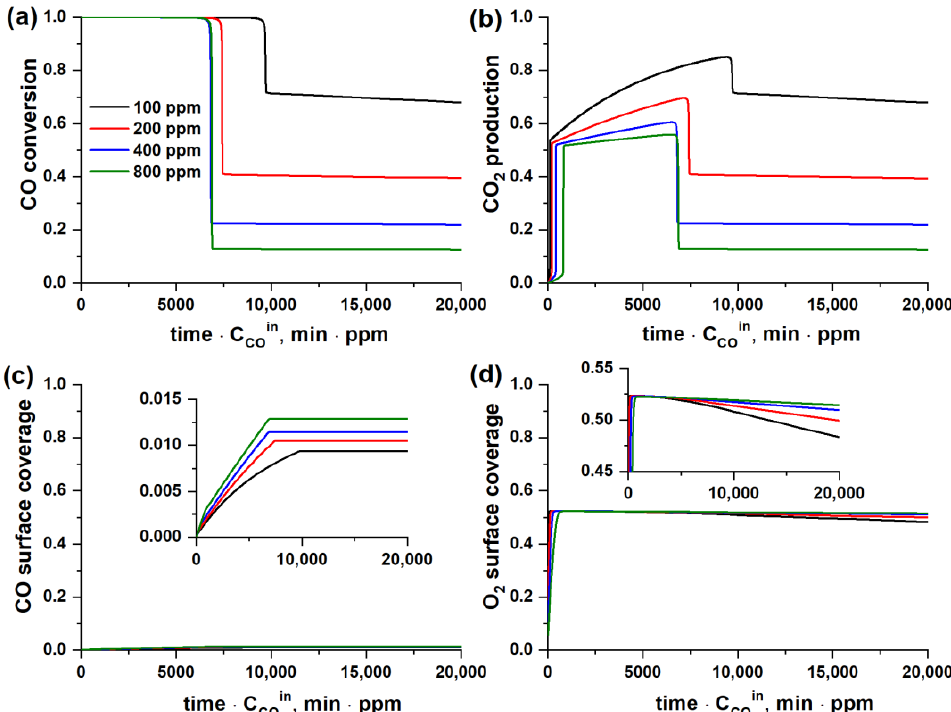
Figure 11. The calculated dependencies of CO conversion, CO 2 production, and the coverages of